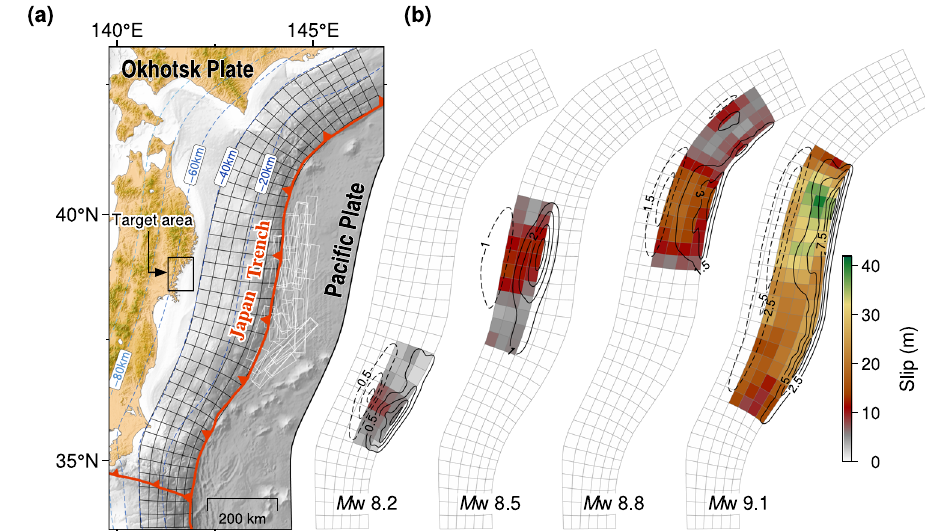
megathrust fault. The dashed and solid black contours indicate the coseismic subsidence and uplift, respectively, with intervals of 0.5m for M w 8.2, 1m for M w